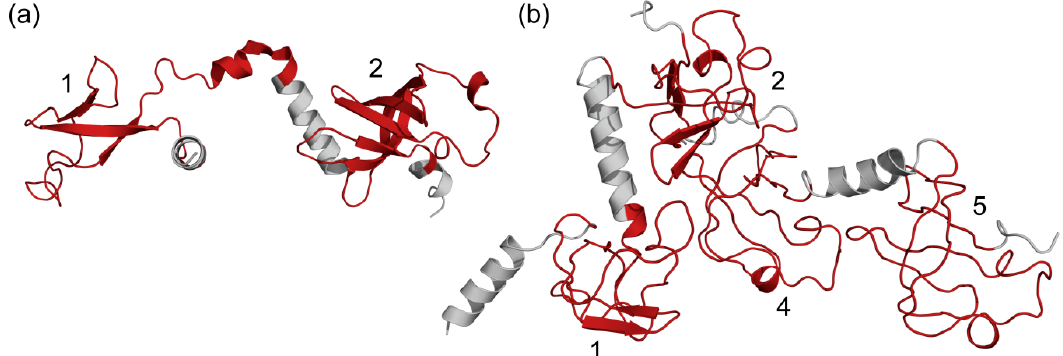
Figure 5. ( a ) 30S ribosomal protein S1 from E. coli as a part of structure of viral RNA polymerase, PDB code: 4q7j (Chain: D), ( b ) Structure of ribosomal protein S1 from E. coli as a part of hibernating 100S ribosome, PDB code: 6h4n (Chain: y).